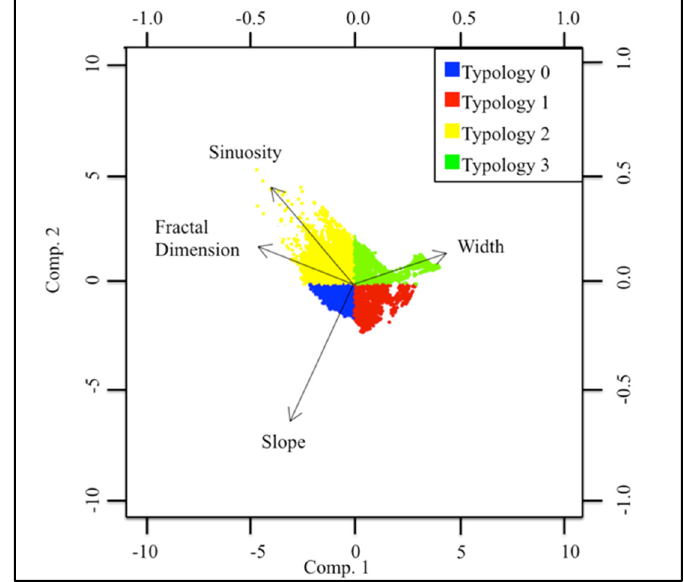
Figure 4. Biplot of PCA scores (colour coded by typology), with the four variable geomorphological vectors (sinuosity, slope, fractal dimension, stream width) plotted in relation to principal components 1 ( x axis, 49% variation) and 2 ( y axis, 24% variance).